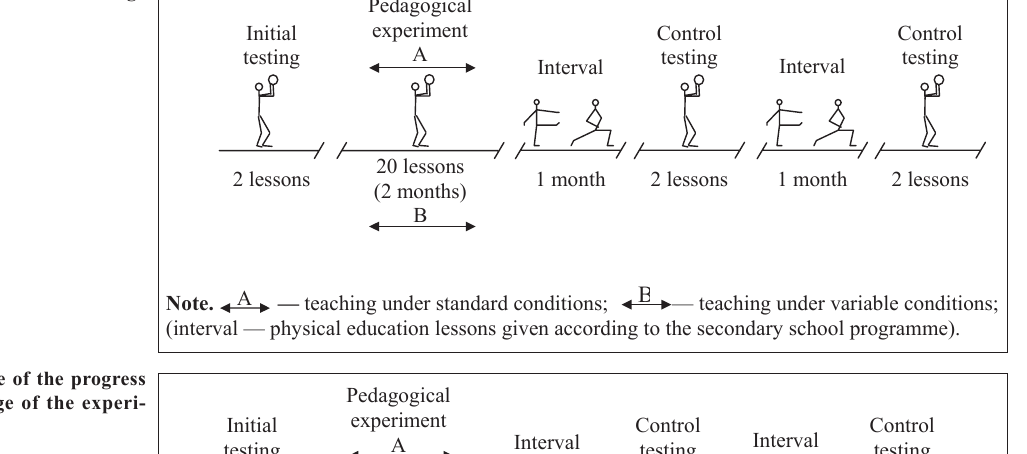
Fig. 1 The scheme of the fi rst stage of the experiment